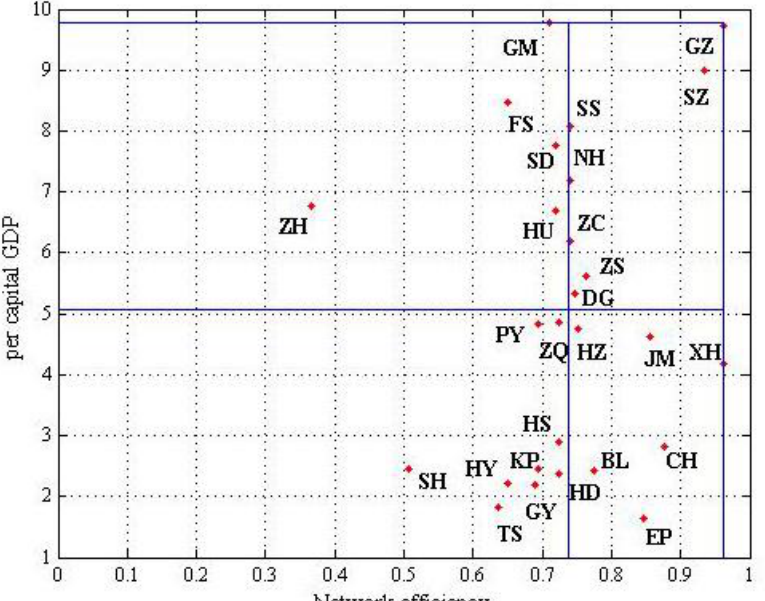
Figure 6: Network efficiency vs. per capital